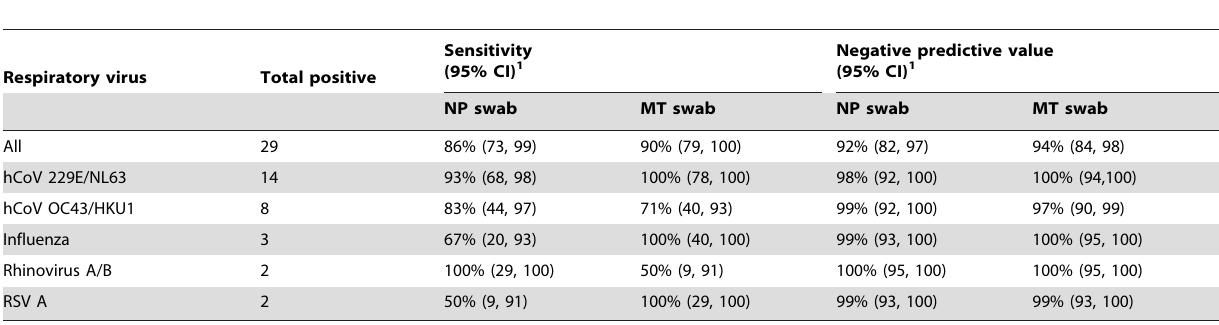
Table 1. Sensitivity and negative predictive value of mid-turbinate swabs and nasopharyngeal swabs compared to combined results for the diagnosis of viral infection in adults with acute respiratory illness.